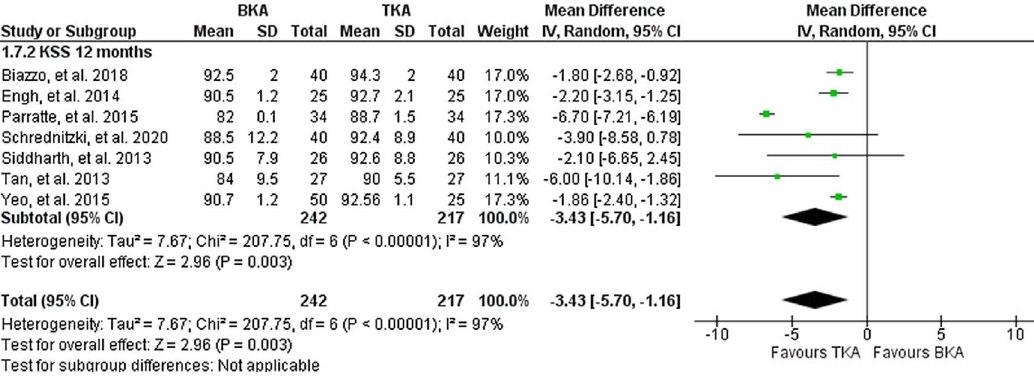
Figure 5. Forest plot of comparison: BKA vs TKA, outcome: KSS after 12